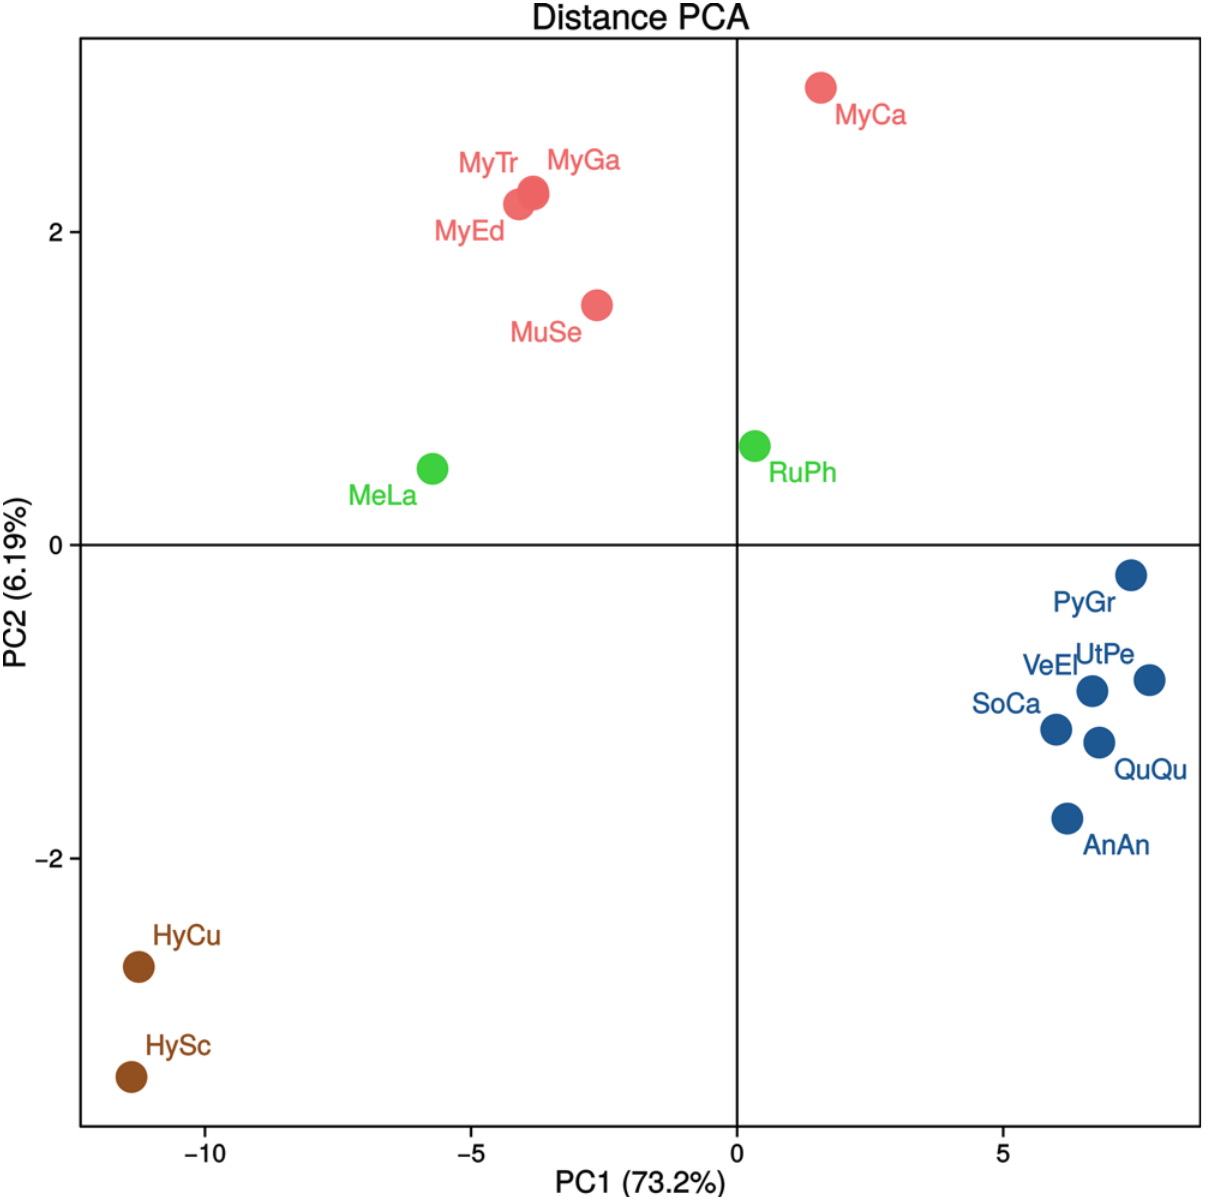
Fig 5. PCA plot. Principal Component Analysis (PCA) based on both Jin-Nei and Kimura distances reported in Table 4. Colors refer to different families: blue, Unionidae with the exception of Hyriopsis spp. (brown; see text for details); Indian red, Mytilidae; green, Veneridae. AnAn, Anodonta anatina ; HyCu, Hyriopsis cumingii ; HySc, Hyriopsis schlegelii ; MeLa, Meretrix lamarckii ; MuSe, Musculista senhousia ; MyCa, Mytilus californianus ; MyEd, Mytilus edulis ; MyGa, Mytilus galloprovincialis ; MyTr, Mytilus trossulus ; PyGr, Pyganodon grandis ; QuQu; Quadrula quadrula ; RuPh, Ruditapes philippinarum ; SoCa, Solenaia carinatus ; UtPe; Utterbackia peninsularis ; VeEl, Venustaconcha ellipsiformis